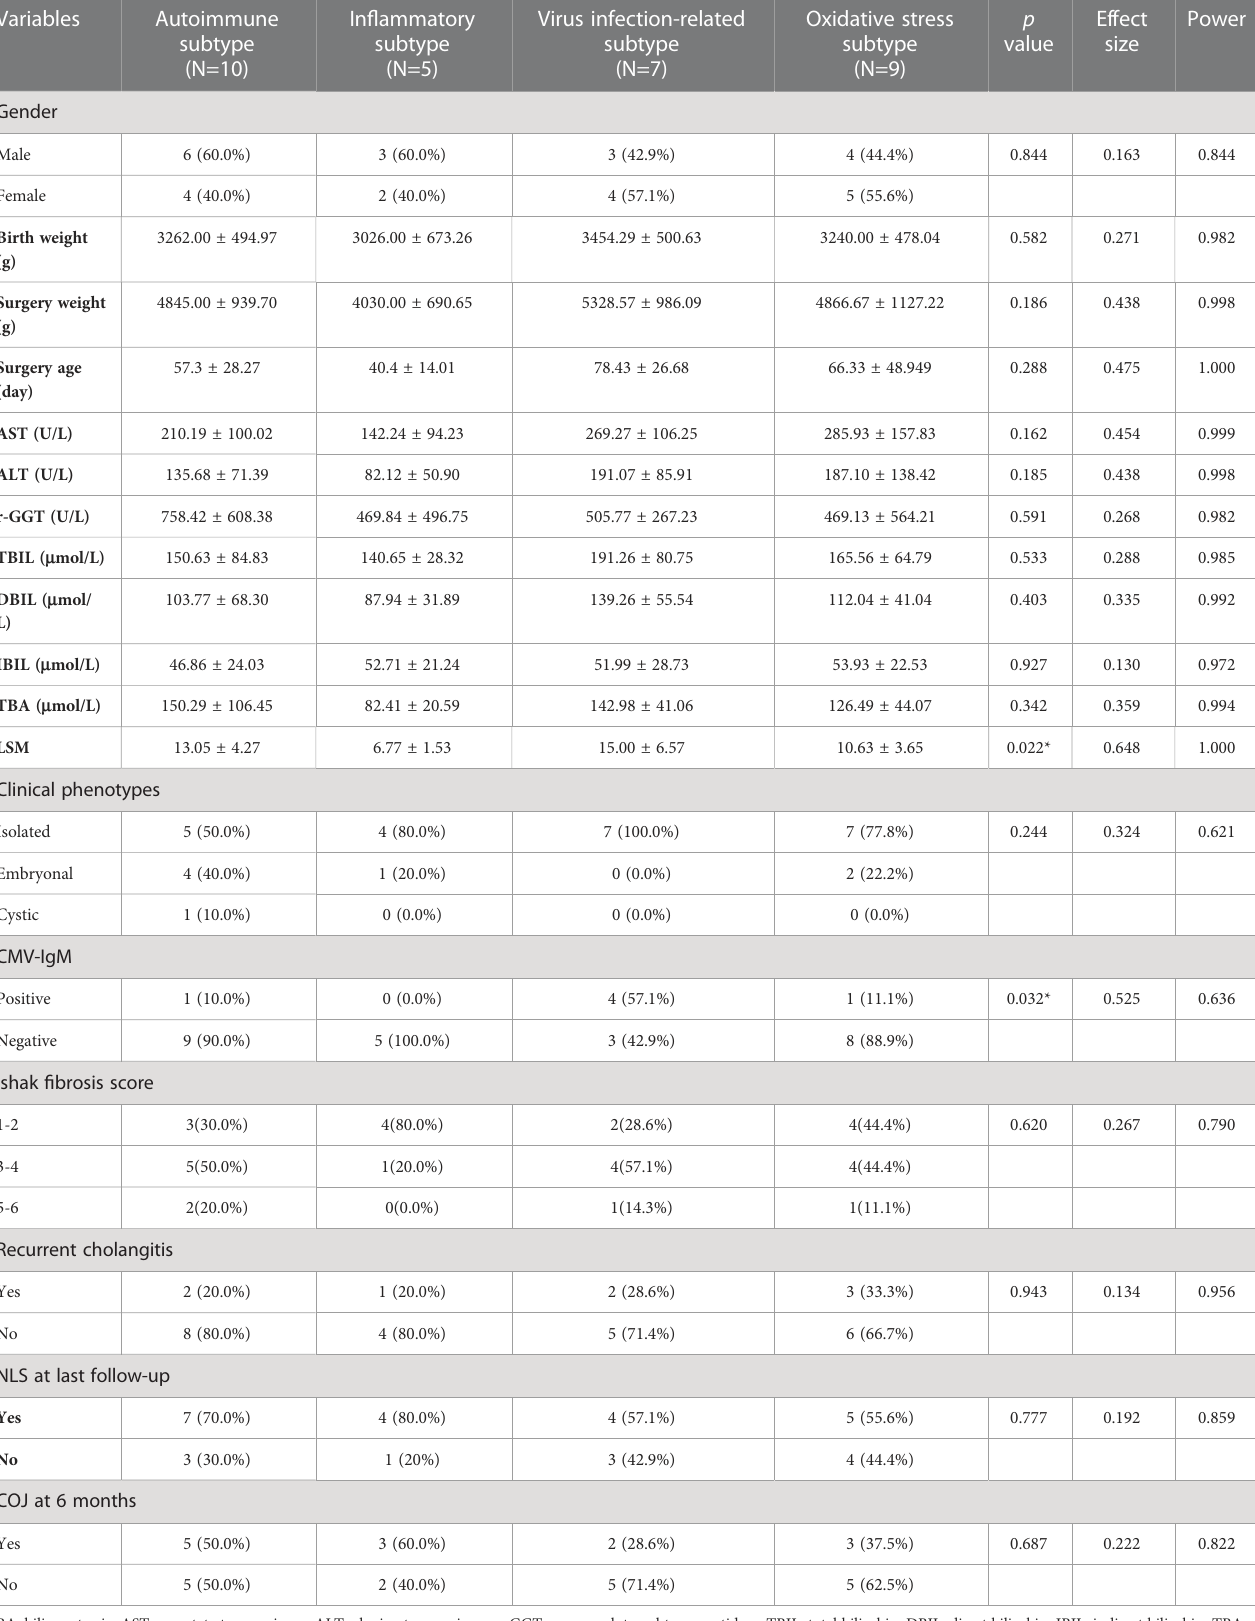
TABLE 1 Clinicopathological features between four molecular subtypes in 31 BA